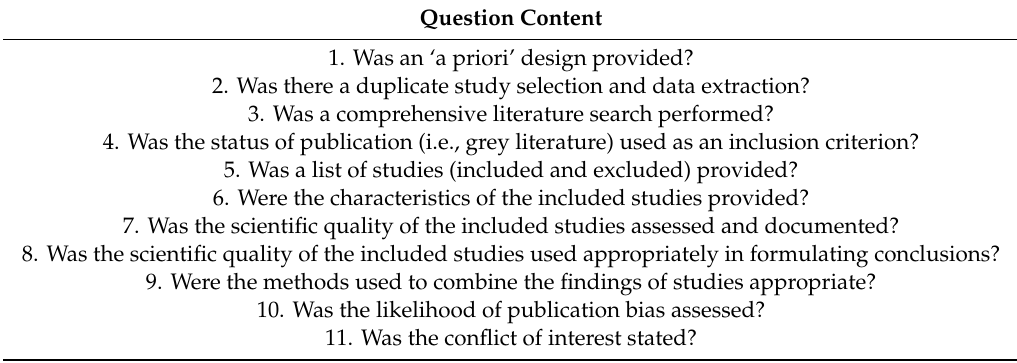
Table 1. Question content of the assessment of multiple systematic reviews (AMSTAR).